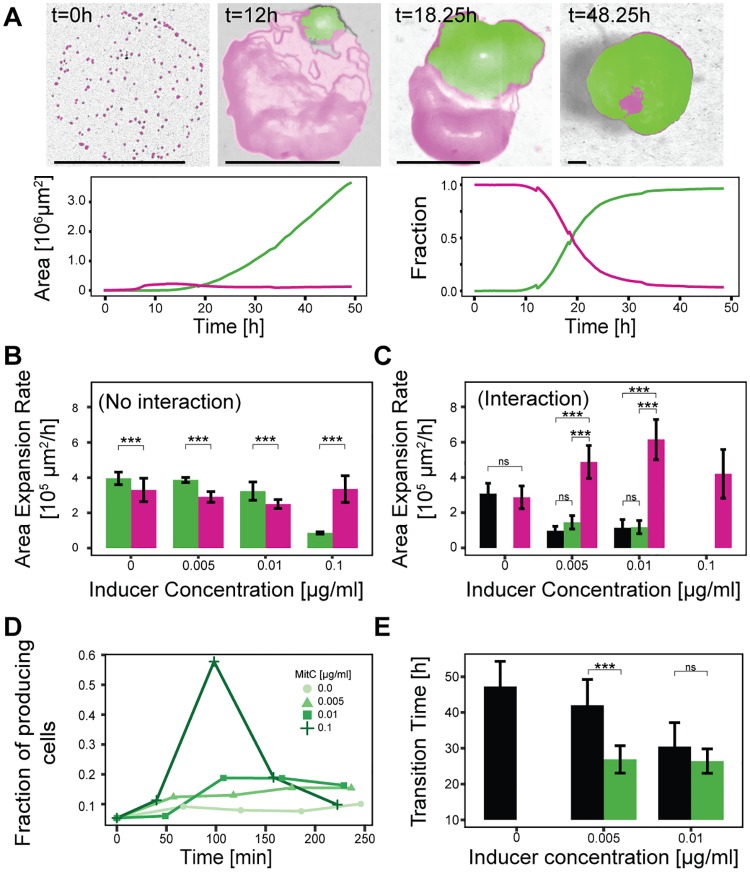
Characterization of interaction dynamics.The increase of the toxin producer fraction and not the ColicinE2 producer strain (C strain) growth rate determines the change in outcome distributions. Unless otherwise stated, colors indicate competition outcome (magenta: sensitive strain, green: producer strain, grey/black: coexistence), error bars represent mean ± standard deviation. (A) Sample image time series and corresponding area and relative fraction curves show C domination outcome (0.01 μg/ml MitC). Scale bar represents 400 μm. (B) Average expansion rates of single-strain colonies obtained in control experiments (no interaction). (C) Effective expansion rates of the entire S–C colony during competition (interaction present). Colors indicate the outcome of the competition: e.g., magenta indicates that >90% of S are present and responsible for colony expansion. (D) Temporal evolution of the producer fraction in the C population in high-resolution control experiments (Methods). (E), The dependence of transition time (time taken for C to capture more than 50% on the colonized area) on inducer concentration. (B, C, E: asterisks indicate significant differences as obtained by pairwise t-tests; not significant (ns): p > 0.05, ***: p < 0.001, for details see S1 Data).